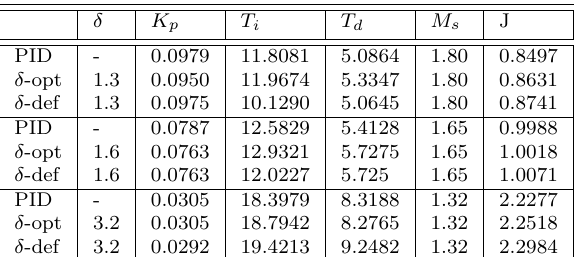
Table 3: PO-PID parameters. Comparing with opti- mal δ -tuning and δ -tuning with ¯ c = 2 . 5 and γ = 2 . 1.